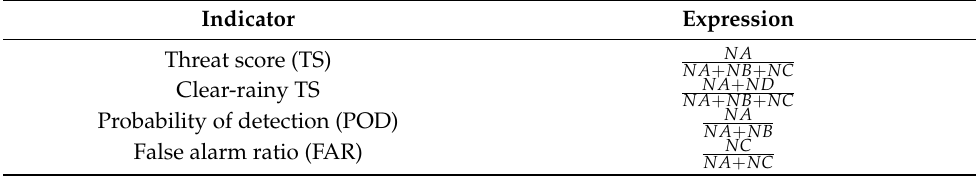
Table 5. Assessment indicators used in multi-model and sensitivity experiments. NA , NB , NC , and ND represent the number of hits, misses, false alarms, and correct negatives,